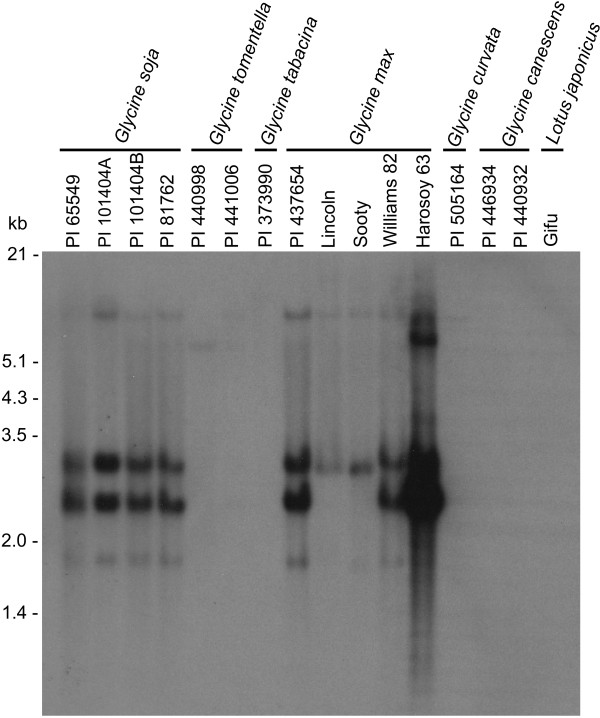
Hybridization of Hps cDNA to genomic DNA from seven different legume species. Genomic DNA (30 μg each lane) was digested with Bgl II and separated by agarose gel electrophoresis. The DNA was transferred to Nylon blotting membrane and probed with 32P labelled Hps cDNA (GenBank accession number AF100159). The name of the line or cultivar is shown above each lane along with species name in italics. The migration of DNA size standards is shown on the left.